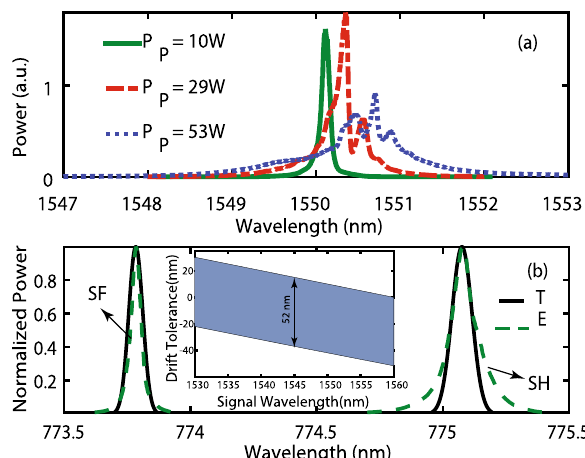
Figure 3. ( a ) Pump spectra for different integrated pump powers. ( b ) Theoretical (T) and experimental (E) results of simultaneous SFG and SHG when the pump and control signal are at 1550.16 nm and 1545 nm, respectively and the pump power is around 20 W. The inset shows the region of tolerable drift in the pump central wavelength at 1550 nm for different signal wavelengths. For the pump central wavelength at 1550 nm, the drift bandwidth is 52 nm for the signal within the